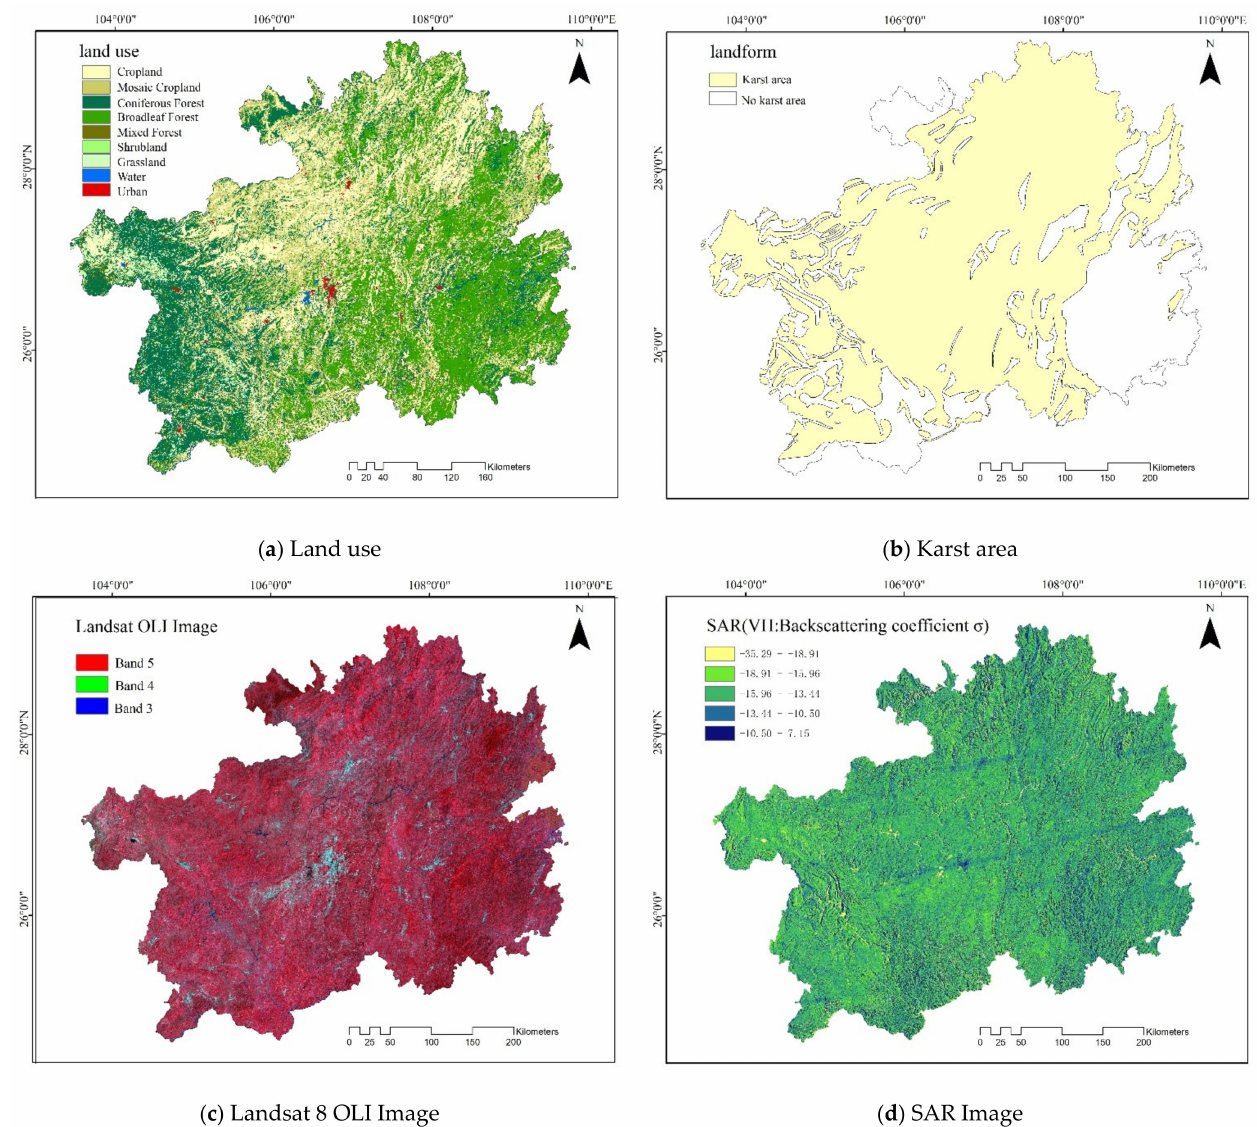
Figure 2. Research dataset (( a ) from European Space Agency; ( b ) from Karst Data Center; ( c ) and ( d ) from Google Earth